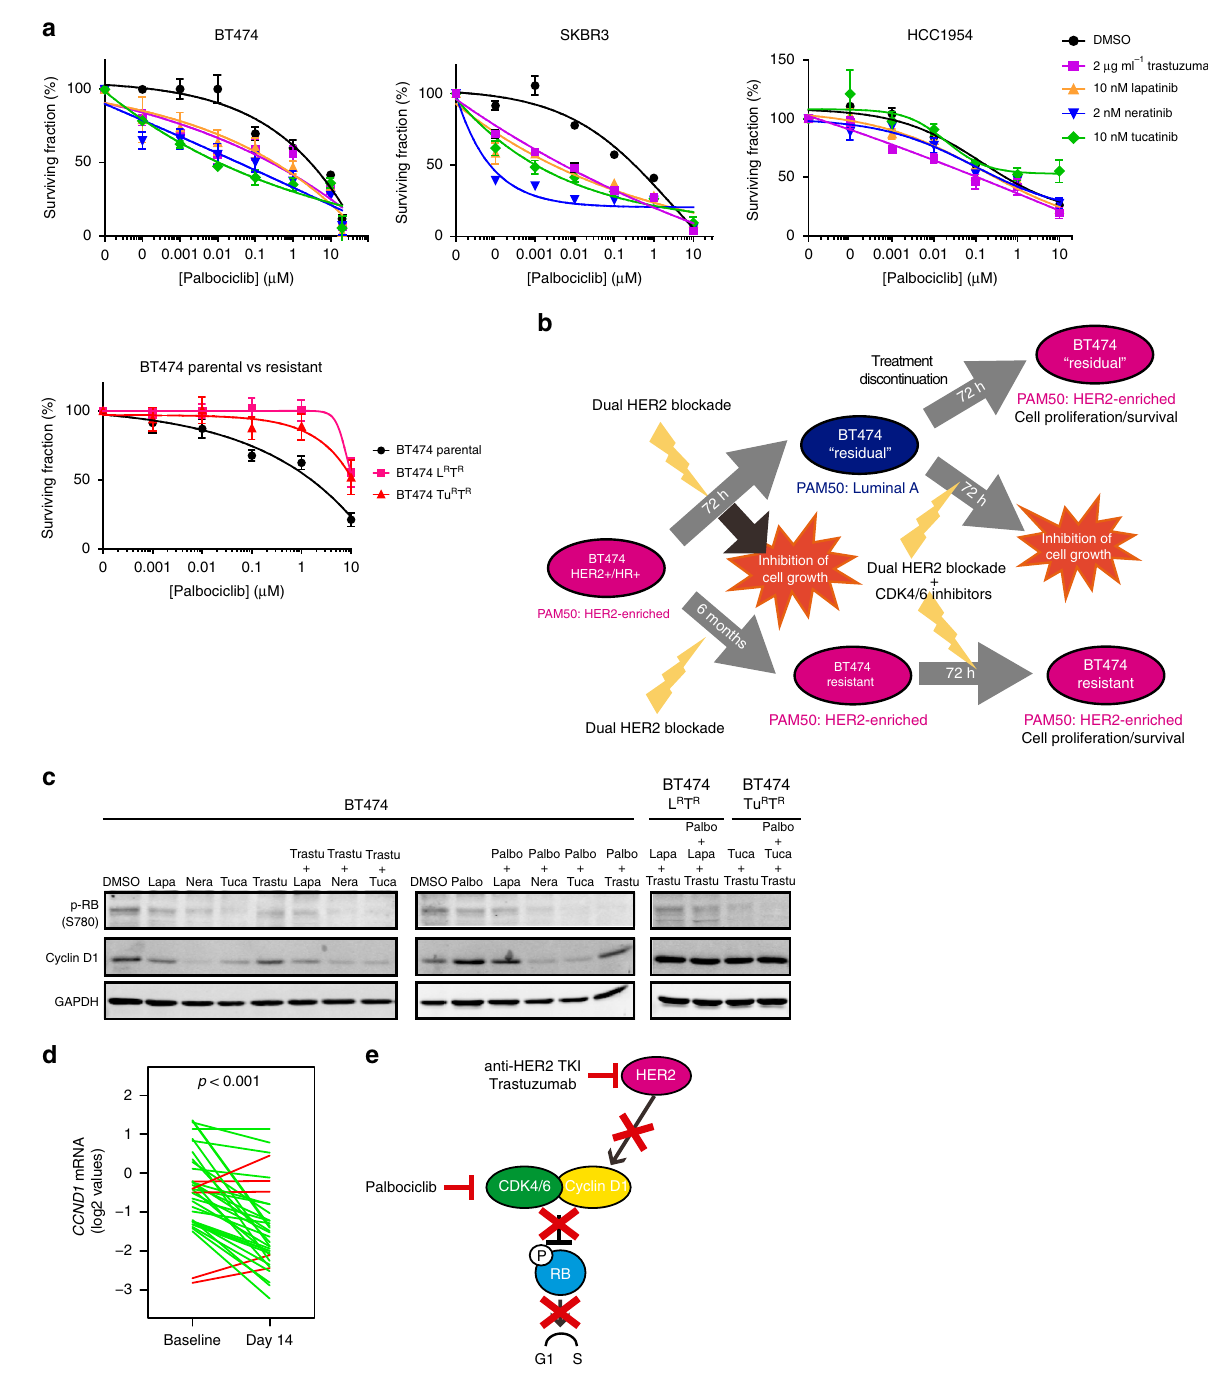
Fig. 5 Shift to Luminal A sensitizes cells to anti-CDK4/6 treatments. a Dose – response curve of BT474, SKBR3, HCC1954, BT474-derived lapatinib and trastuzumab resistant (BT474-L R T R ) and BT474-derived tucatinib and trastuzumab resistant (BT474-Tu R T R ) cells upon treatment with anti-HER2 drugs for 24h and subsequent treatment with anti-HER2 plus increasing concentrations of palbociclib for 72h. Surviving fraction was assessed by staining with Hoechst 33342. Data points represent the mean; error bars represent the standard error of the mean of 3 independent experiments. b Schematic representation of HER2-E breast cancer cells that are sensitive to dual HER2 blockade treatment, which triggers cell growth inhibition but also a shift to a Luminal A molecular phenotype in residual cells. These changes are reversible after treatment discontinuation, while inhibition of HER2 improves sensitivity to CDK4/6 targeted therapies. BT474 resistant to anti-HER2 treatments remain HER2-E and do not respond to inhibition of HER2 and CDK4/6. c Western Blot assessing the phosphorylation of RB and the expression of Cyclin D1 in BT474 cells upon 24h of treatment with 10nM TKI (lapatinib, neratinib, tucatinib), with 10 µ g ml − 1 trastuzumab, with the combination of TKI plus trastuzumab, 10nM palbociclib or with the combination of palbociclib with anti- HER2 treatments, and in BT474-L R T R and BT474-Tu R T R treated with 2 µ g ml − 1 trastuzumab + 2 nM TKI (lapatinib and tucatinib respectively) with or without palbociclib. ( d ) CCND1 mRNA levels in HER2 + /HR + tumors of the PAMELA trial at baseline and day 14. Each line represents a paired sample. Increases are represented in red and decreases in green. P -value ( p ) was determined by two-tailed paired t -tests. ( e ) Schematics of the mechanism by which double-targeting the HER2 and CDK4/6 pathways can prevent RB phosphorylation and arrest cell cycle. Source data are provided as a Source Data fi